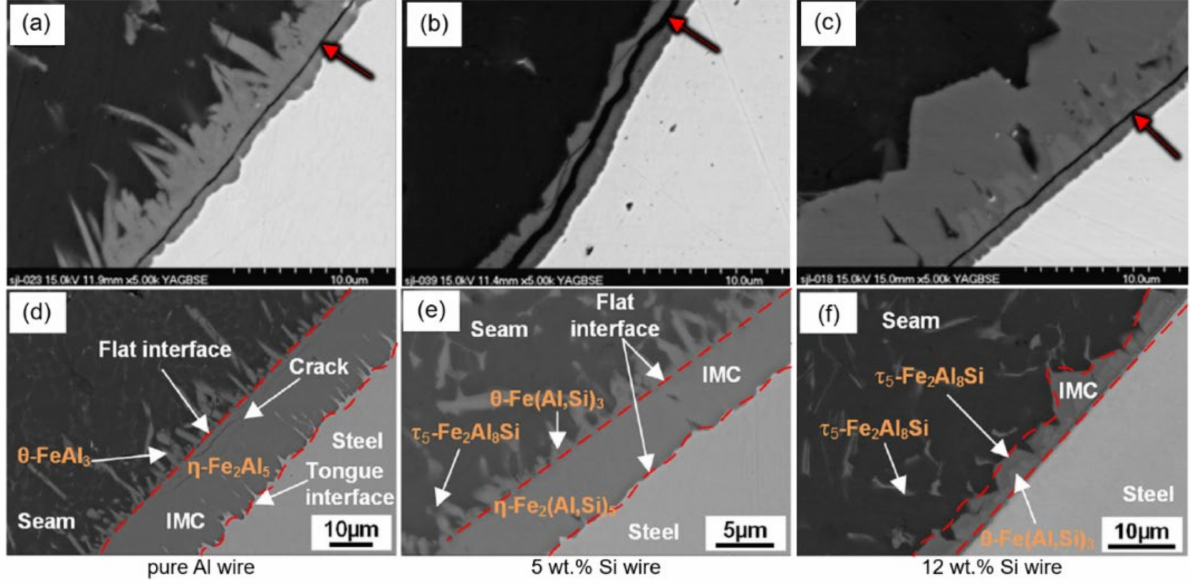
Figure 11. Effect of filler wire on the evolution of the Fe–Al IMC layer with TIG brazing [103]: ( a ) pure Al wire; ( b ) 5 wt.% Si wire; ( c ) 12 wt.% Si wire. Red arrow indicates crack path position. Laser brazing results [99]: ( d ) pure Al wire; ( e ) 5 wt.% Si wire; ( f ) 12 wt.% Si